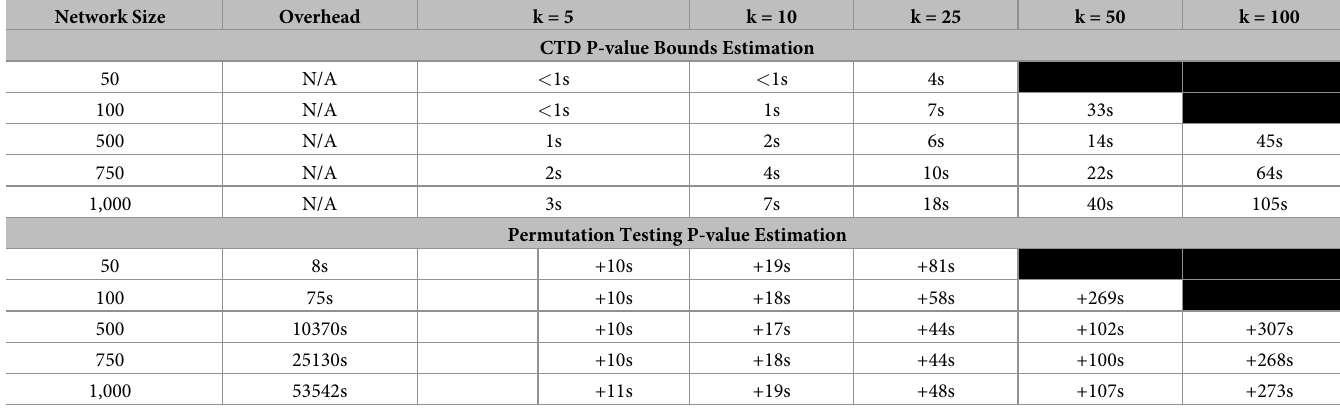
employed three different network clustering methods: InfoMap [23], Greedy Modularity Opti- mization (GMO) [24], and WalkTrap [25]. Metabolites selected by each of the feature selection methods are outlined in S3 Table . To indicate the relevance of each metabolite selected by each feature selection method, we have highlighted known biomarkers for each diagnostic cat- egory in green and novel clinically relevant metabolites not previously identified in Miller et al. (2015) in yellow. Purple-highlighted metabolites are perturbed as a result of medication or diet treatment for the disease of interest. While inclusion of just one known biomarker for each of the 5 inborn error of metabolism disorders modeled often resulted in a perfect ROC-AUC across all feature selection methods, inspecting the metabolites selected by each approach revealed interesting differences ( S3 Table ). While all feature selection methods can Table 1. Execution time (in seconds) of CTD p-value bounds compared to using permutation testing for a variety of network and subset sizes. In the following tim- ing experiments, each network was approximately 20% connected. Times for CTD’s p-value bounds estimation are reported as the average execution time observed in